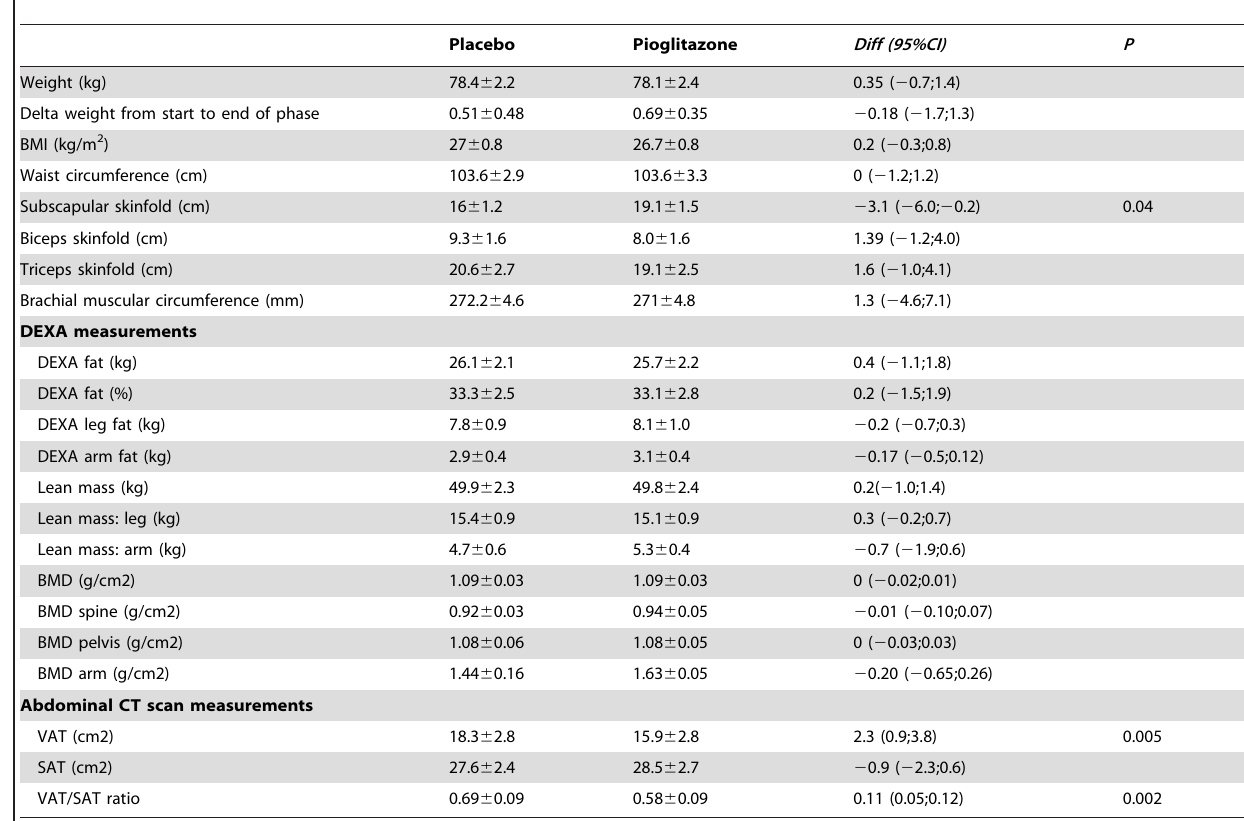
Table 2. Body composition measurements at termination of placebo and pioglitazone phases.